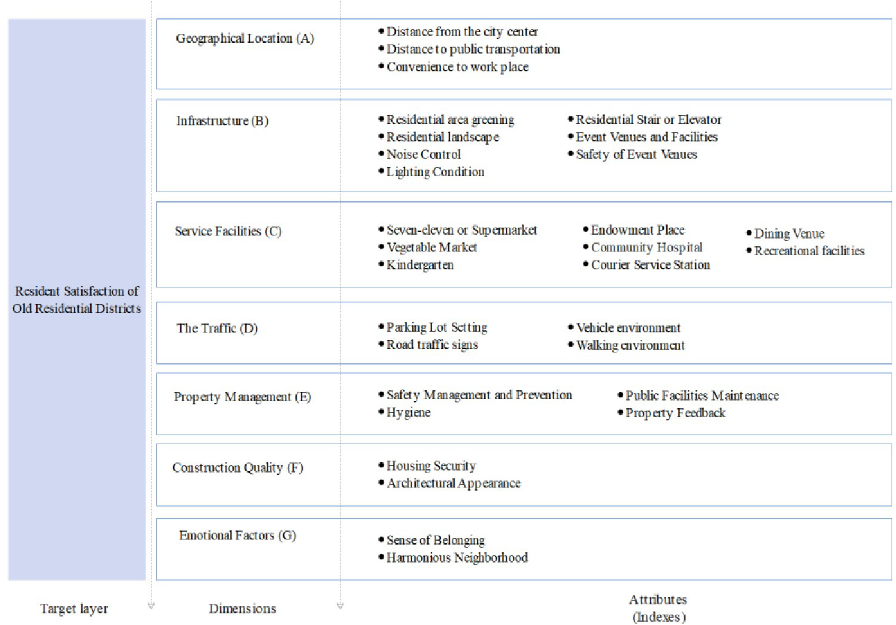
Fig 7. Index system for the renovation of old residential